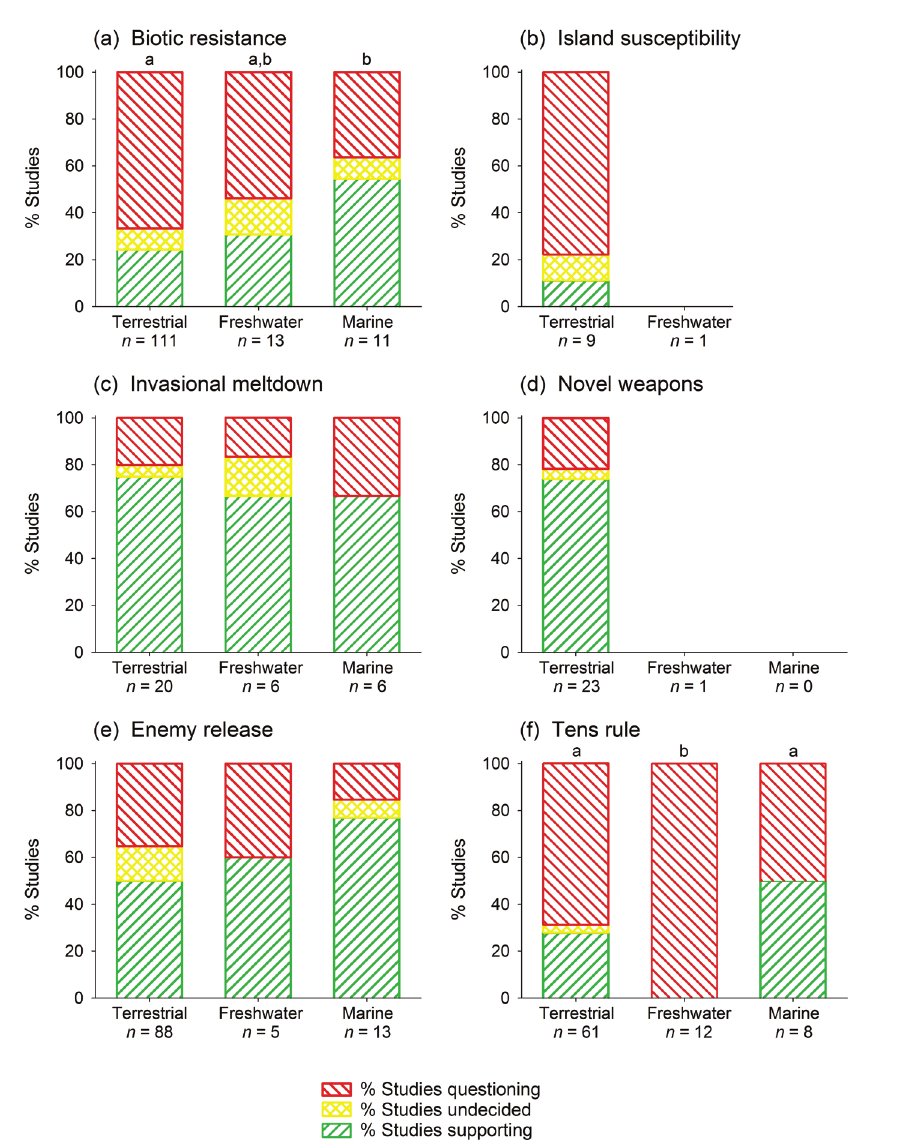
Figure 5. Level of empirical support for six of invasion biology’s major hypotheses, subdivided by habi- tats. The few studies that covered more than one of the three habitats were counted for each habitat. Missing bars indicate lacking data: bars are only shown if at least 5 studies were carried out for a given hy- pothesis and habitat. Note that the island susceptibility hypothesis is not applicable to the marine habitat. Letters in (a) and (f) indicate significant differences between habitats (U tests, p < 0.05). No significant differences were observed for the other